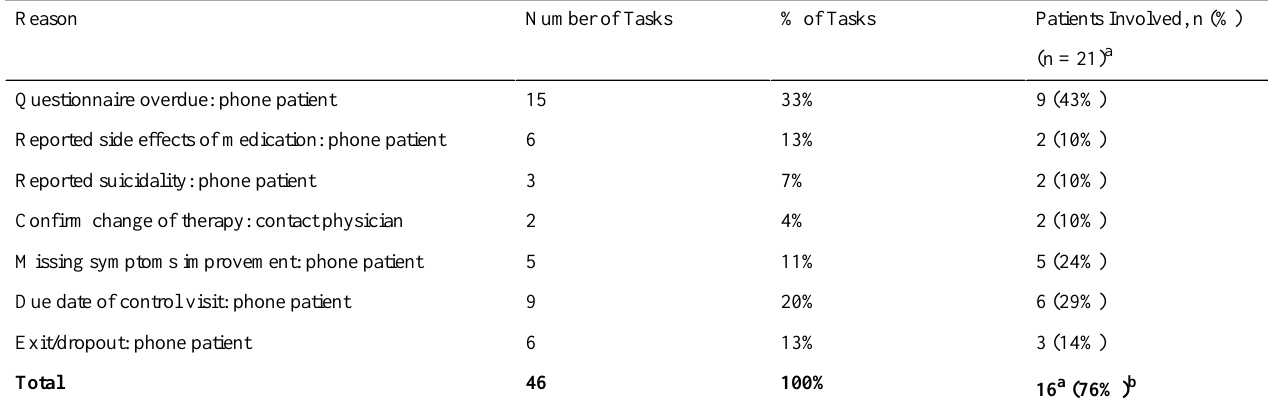
Table 5. Care manager